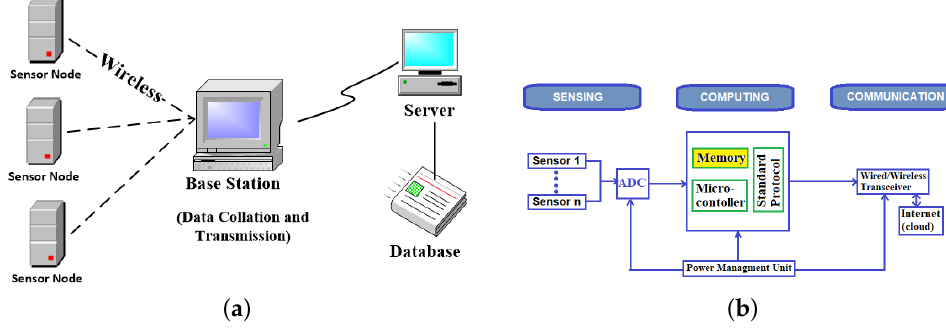
Figure 1. ( a ) IoT-based wireless sensor network. ( b ) Wireless sensor node architecture [2].